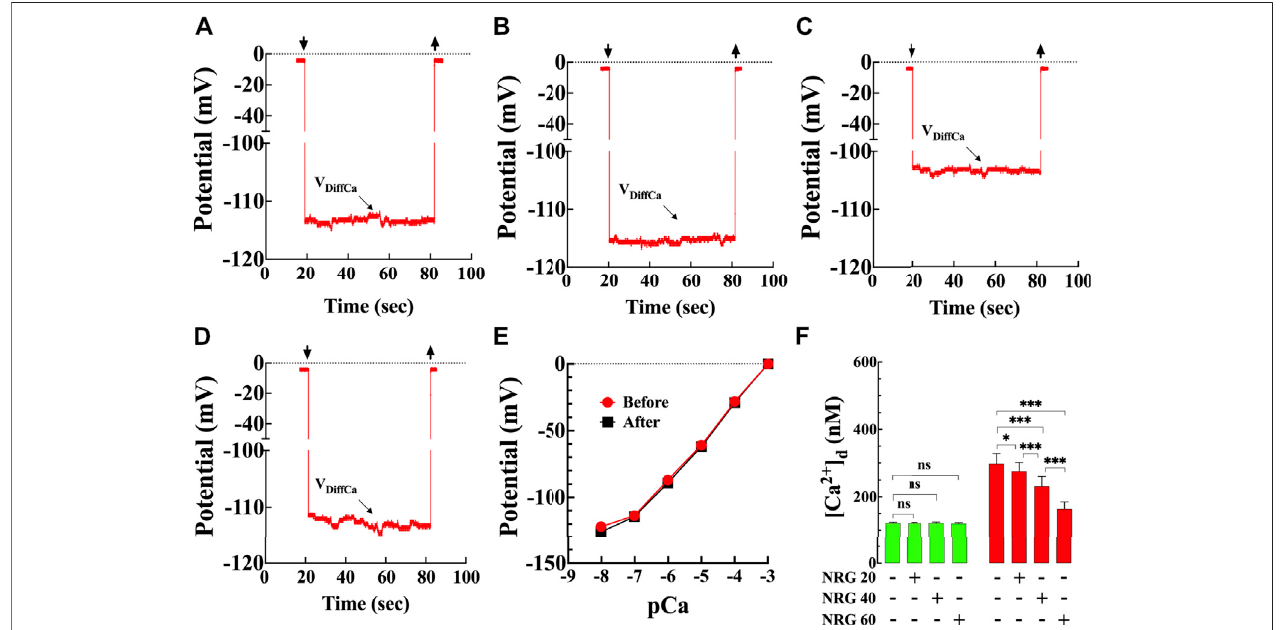
FIGURE 1 | Effects of naringin on diastolic [Ca 2+ ] in T2D cardiomyocytes. Representative traces of [Ca 2+ ] d recorded from enzymatically isolated mouse ventricular cardiomyocytesusingdouble-barreledion-selectivemicroelectrodes. (A) controlwithnotherapeuticintervention,[Ca 2+ ] d (cid:1) 124 nM.Topleftarrow:Ca 2+ microelectrode cell impalement, and top right arrow: microelectrode cell withdrawing. (B) control treated with naringin (60 mg/kg i. p.), [Ca 2+ ] d (cid:1) 119 nM. (C) T2D with no therapeutic intervention, [Ca 2+ ] d (cid:1) 306 nM. (D) T2D treated with naringin (60 mg/kg i. p.), [Ca 2+ ] d (cid:1) 170 nM. The V DiffCa potential was converted to [Ca 2+ ] using the corresponding microelectrode calibration curve. (E) Typical calibration curves of submicron tip Ca-sensitive microelectrodes before and after [Ca 2+ ] d determinations (Lopez et al., 1985; Eltit et al., 2013). The microelectrode shows a Nernstian slope (28.5 mV per pCa unit) (pCa (cid:1) − log [Ca 2+ ]) between pCa 3 and pCa 7 and still have a helpful response between pCa7 and 8. (F) Dose-response effects of naringin on [Ca 2+ ] d measured in quiescent cardiomyocytes isolated from control (green) and T2D mice (red). [Ca 2+ ] d was signi fi cantly higher in T2D than control cardiomyocytes ( p < 0.001). Naringin reduced signi fi cantly [Ca 2+ ] d in a dose-dependent manner in T2D cardiomyocytescomparedtountreatedcardiomyocytes( p < 0.001),withnosigni fi canteffectoncontrolcardiomyocytes( p (cid:1) 0.99comparedtountreated).Experiments were conducted in nmice (cid:1) 5 – 20/group and ncells (cid:1) 10 – 21/group. Values are expressed as means ± S.D. Statistical analysis was performed using one-way ANOVA, followed by Tukey ’ s multiple comparison tests, ns p > 0.05, * p < 0.05, *** p <